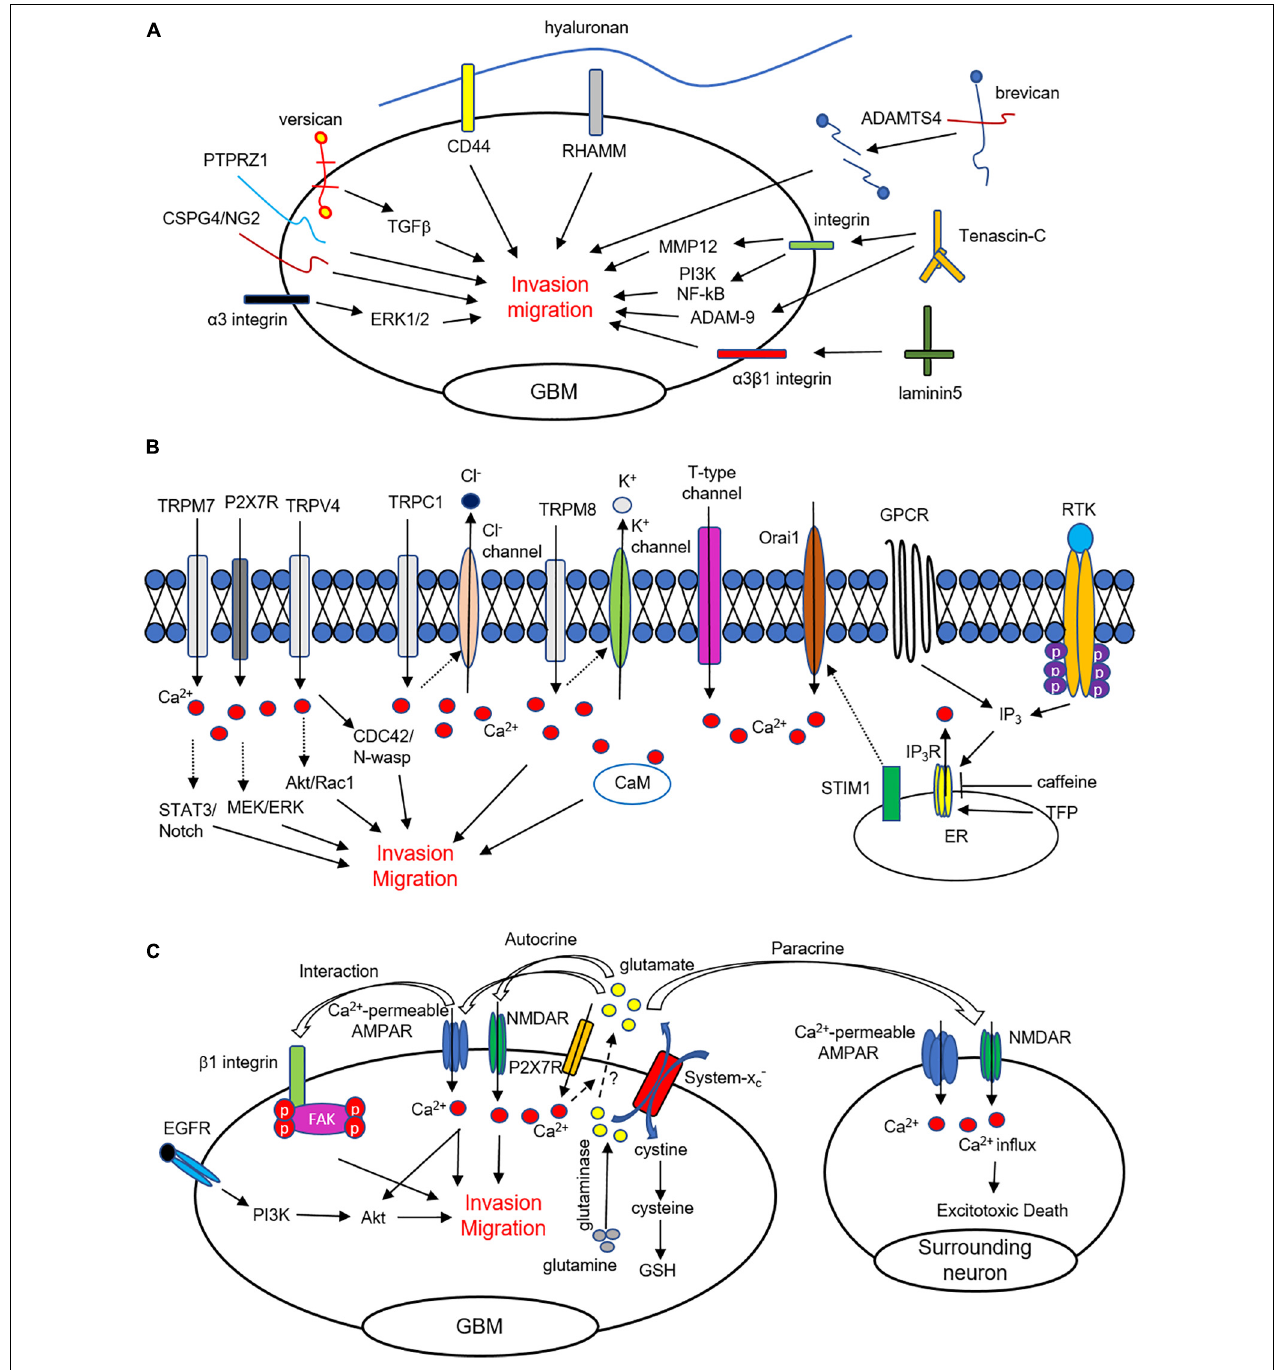
FIGURE 1 | ECM, Ca 2 + signaling, and glutamate mediates invasion and migration in glioma cells. (A) Extracellular matrix and their binding partners regulate invasion and motility in GBM cells. (B) Intracellular Ca 2 + elevation from ER and extracellular region affects glioma cell migration and invasion. Ca 2 + influx through TRP channels, P2 × 7Rs, and t-type Ca 2 + channels are critically involved in glioma cell infiltration. (C) Glioma cells release glutamate through a cysteine-glutamate exchanger (system x C − ). Released glutamate from glioma cells activates Ca 2 + -permeable AMPARs and NMDARs and affects migration and invasion. Sustained Ca 2 + influx causes excitotoxic death of surrounding cells to make microenvironment for invasion.